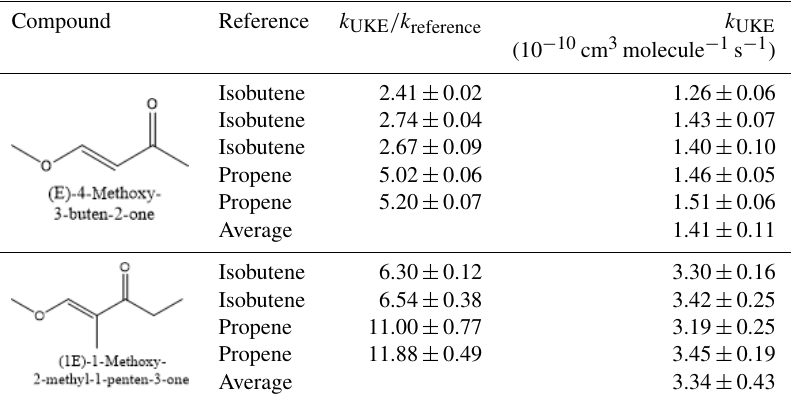
Table 1. Rate coefficient ratio of k UKE /k reference and rate coefficients for the reaction of OH radicals with ( E )-4-methoxy-3-buten-2-one and (1 E )-1-methoxy-2-methyl-1-penten-3-one at (298 ± 3)K in 1atm of